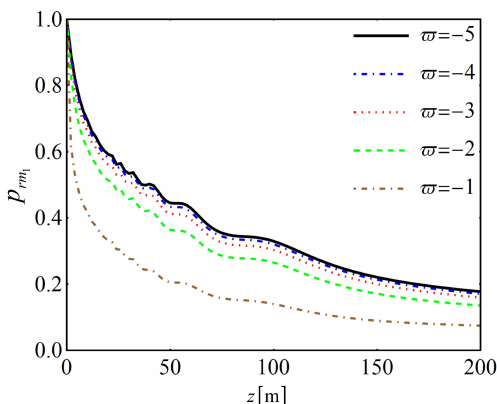
Figure 6. Relative detection probability of signal photon versus propagation distance for different ratios of temperature and salinity contributions to the refractive index (cid:118)